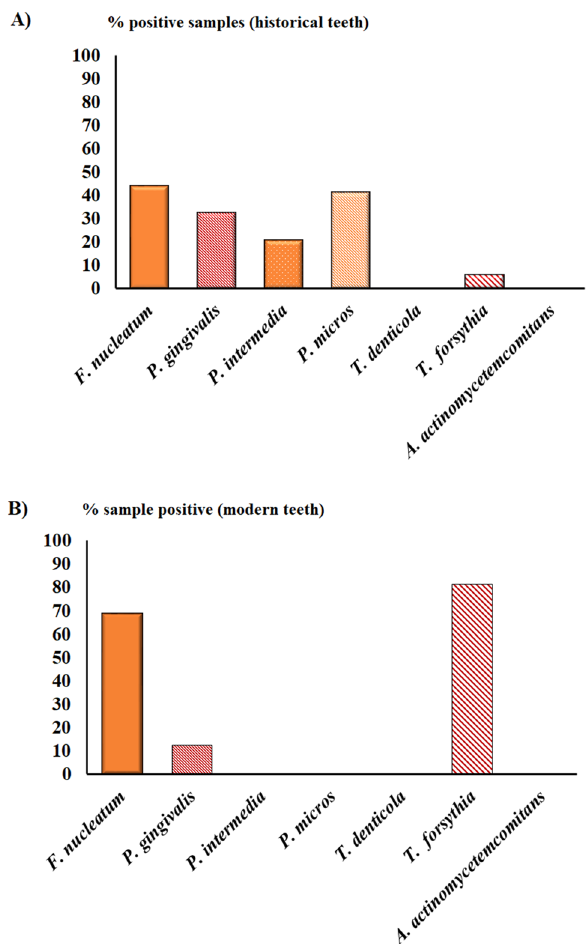
Figure 5. Real-time PCR results. Percentage positive of seven representative periodontal pathogens tested in historical ( A ) and modern groups ( B ). Historical males n = 5, historical females n = 7; modern males n = 12, and modern females n =